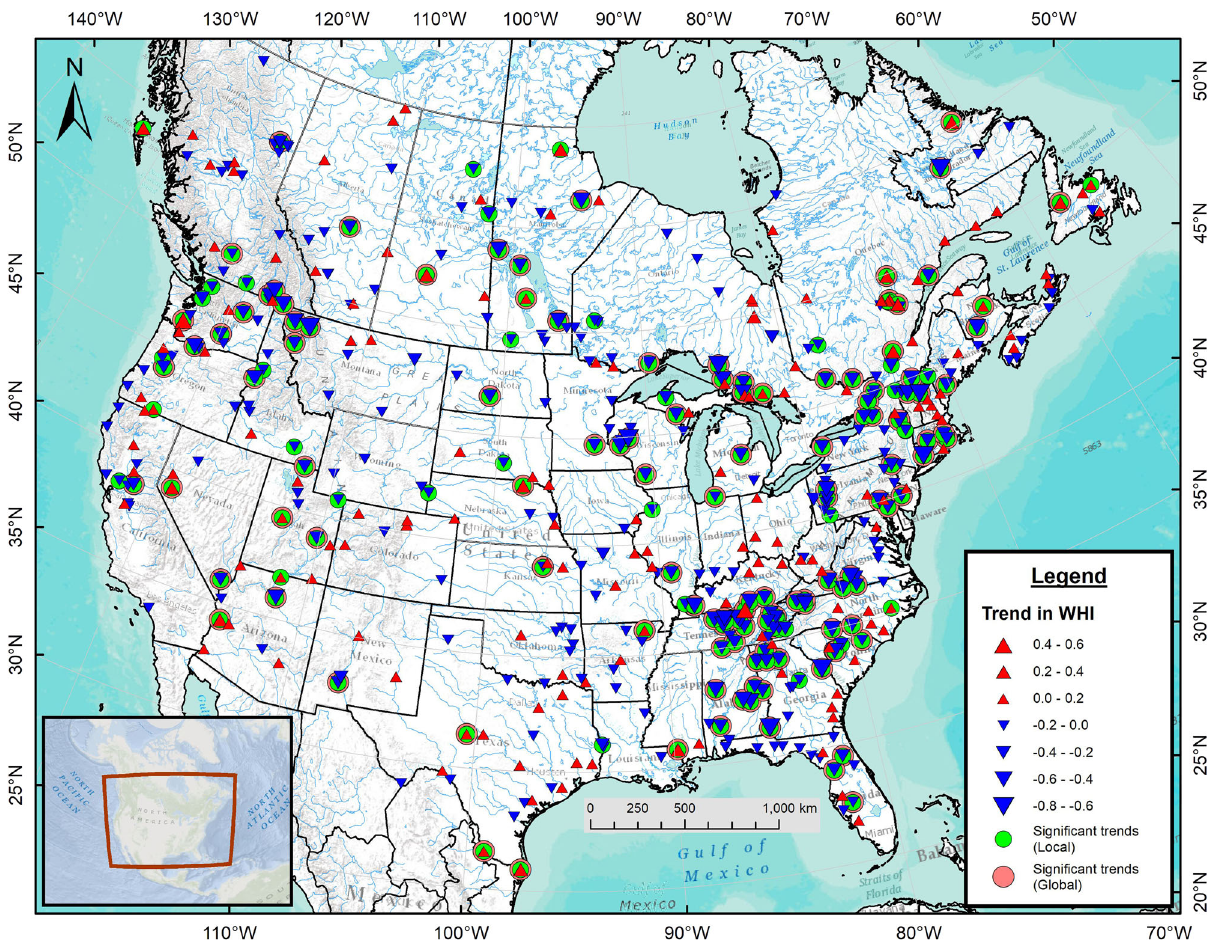
Fig. 6 Map of the 1980 – 2019 monotonic trends in WHI at 479 sites across the USA and Canada. Red upward (blue downward) pointing triangles indicate positive (negative) trends. Trend magnitudes are proportional to the triangle sizes and green circles (pink outlines) indicate locally (globally) statistically signi fi cant trends ( p < 0.05). Results are shown only when n y ≥ 30